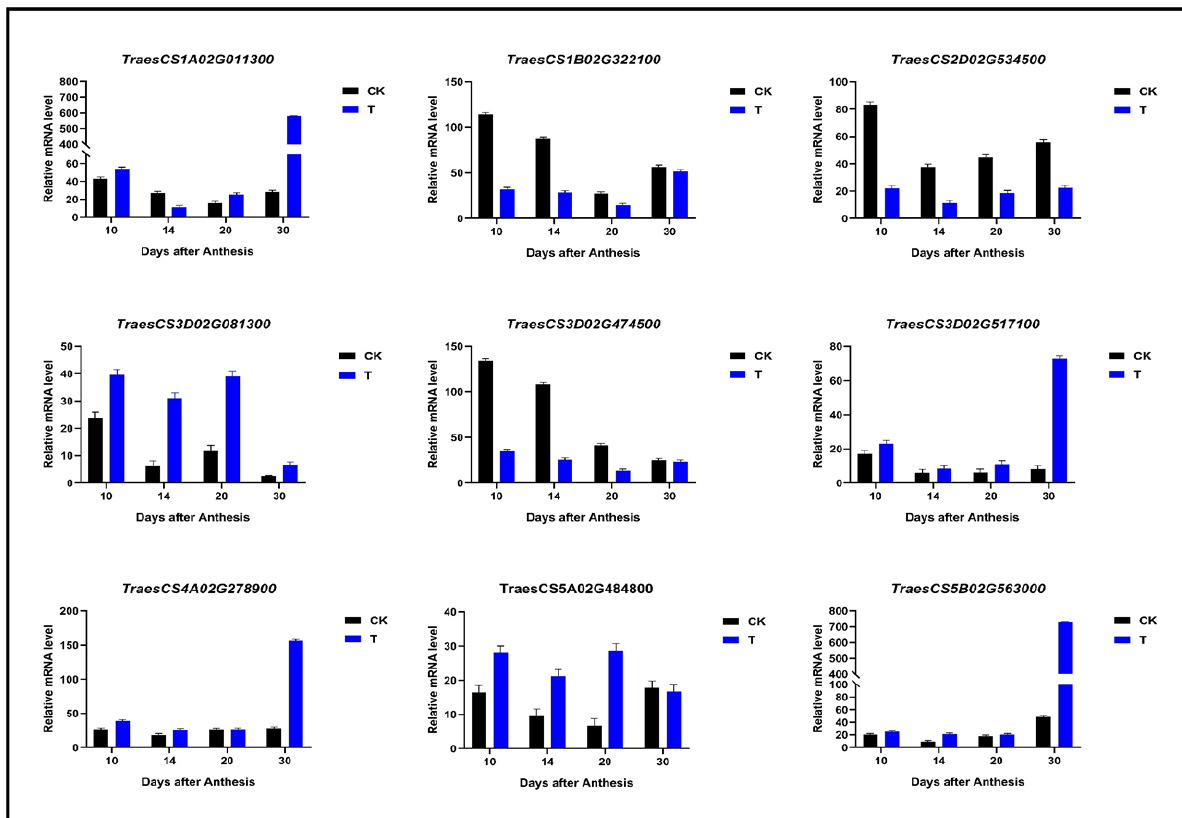
Figure 12. QRT-PCR analysis of 9 randomly selected mRNA expressions from transcriptome database, (T) Shaanong 33 ( Triticum aestivum L.) and CK ( Triticum aestivum L.), at 10, 14, 20, and 30 DPA. Data are means of three biological replicates (n = 3); significant differences at p < 0.05 (ANOVA and Tukey HSD test); means ± SD.